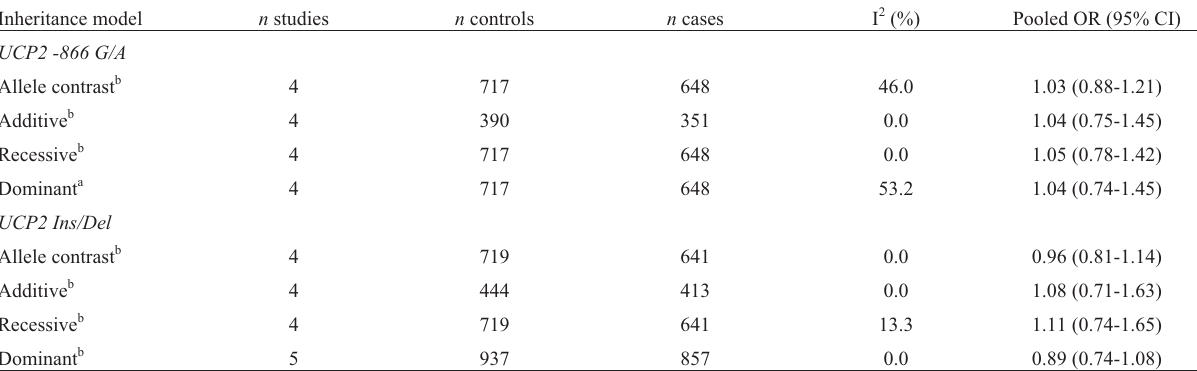
Table 4 - Pooled measures for associations between the UCP2 -866G/A and Ins/Del polymorphisms and susceptibility to DKD. Inheritance